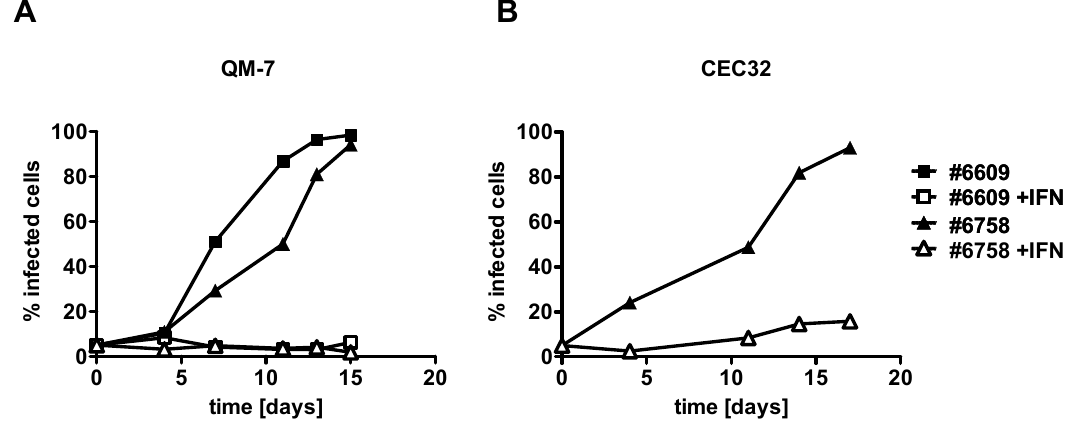
Figure 2. Effect of chicken IFN- α on the de novo infection of QM-7 (A) and CEC32 (B) quail cells with ABV strains #6758 and #6609. Virus exposure of uninfected cultures was started by mixing persistently infected and uninfected cells at an initial ratio of 1:20. The mixed cultures were then plated into two separate dishes which were subsequently kept in either plain medium (closed symbols) or medium containing 100 units per ml of chicken IFN- α (open symbols). The kinetics of virus spread was measured by visualizing ABV-N- positive cells in culture samples using indirect immunofluorescence analysis and by calculating the percentage of virus-infected